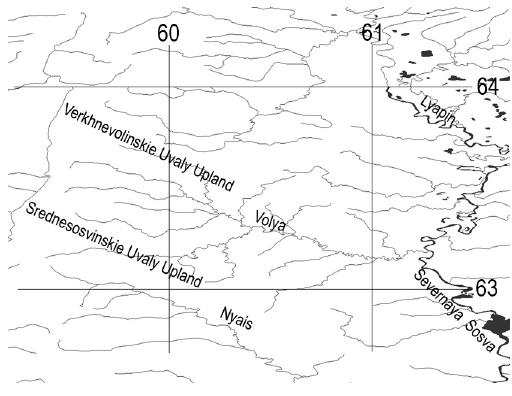
Fig. 5. Map of Tazovsky Peninsula calving